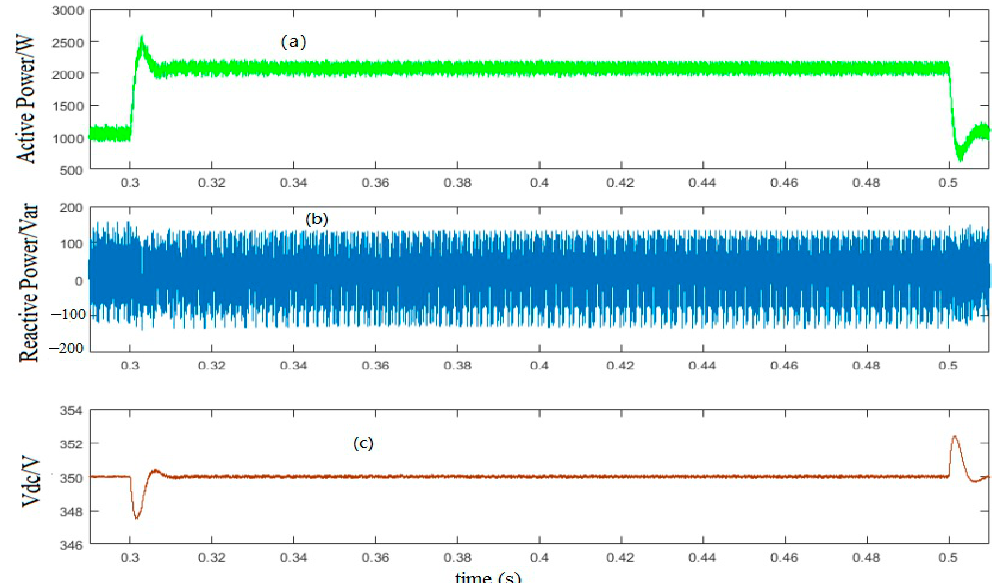
Figure 13. Instantaneous load-unload simulation results by MPDPC with Bayesian estimation method. Figure13. Instantaneous load ‐ unload simulation results by MPDPC with Bayesian estimation ( a ) active power; ( b ) reactive power; ( c ) DC bus method. ( a ) active power; ( b ) reactive power; ( c ) DC bus voltage.